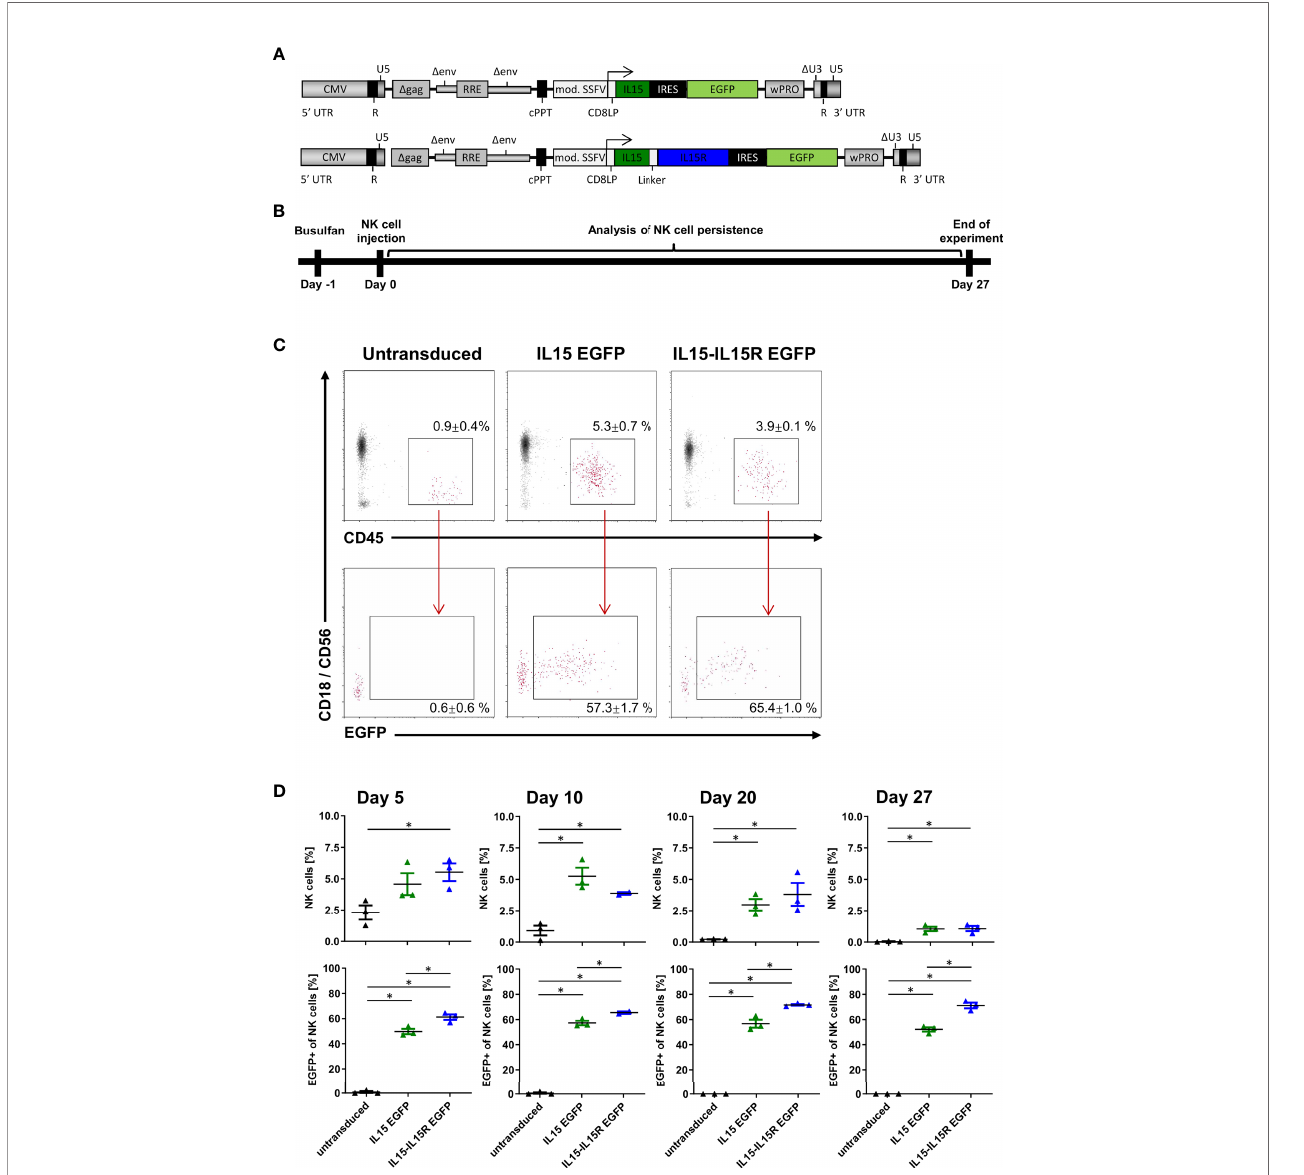
FIGURE 6 | NK cells rely on endogenous IL15 production for in vivo persistence in NSG mice. (A) Schematic representation of the vector maps of the IL15 constructs used for NK cell transduction. (B) Primary human NK cell preparations consisting of 50% EGFP/IL15 or EGFP/IL15-IL15R and 50% untransduced NK cells (or 100% untransduced cells as control group) were injected into busulfan-preconditioned mice (3 animals per group). On days 5, 10, 20, and 27, NK cell persistence in the bloodstream was analyzed by mouse CD18, human CD45, and CD56 staining as well as EGFP expression. (C) Example of gating strategy showing representative data from day 10. Values indicate mean ± SEM of all three animals. (D) NK cell persistence in the blood including ratios of transduced to untransduced NK cells. Data are represented as mean ± SEM. Signi fi cances of p<0.05 are indicated by an asterisk